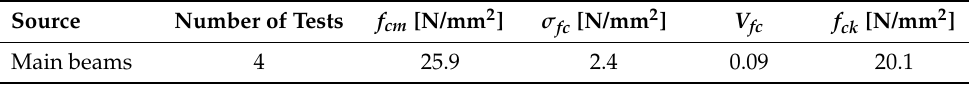
Table 7. Sample parameters for concrete compressive